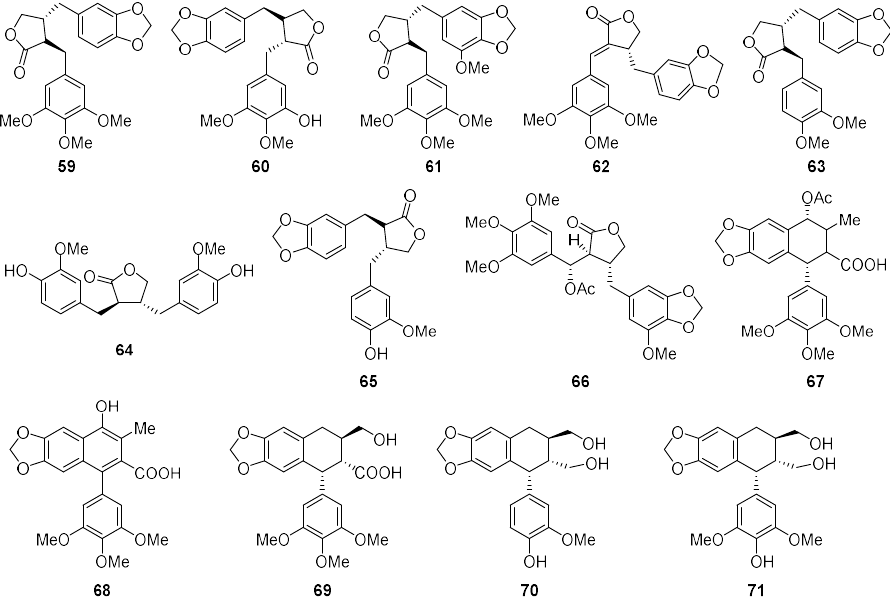
Figure 2. Chemical structures of natural seco-podophyllotoxins.